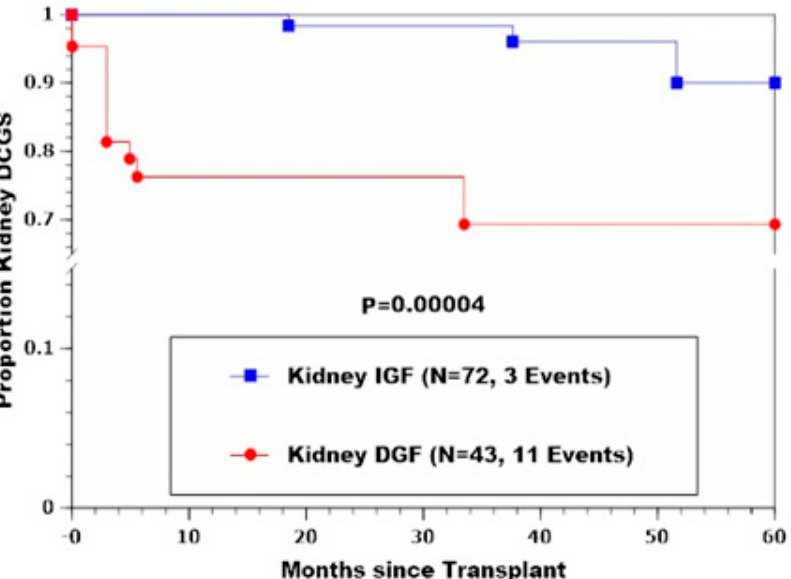
Figure 1. Kidney death-censored graft survival (DGCS) in kIGF and kDGF recipients showing significantly higher rate of graft loss among kDGF patients.